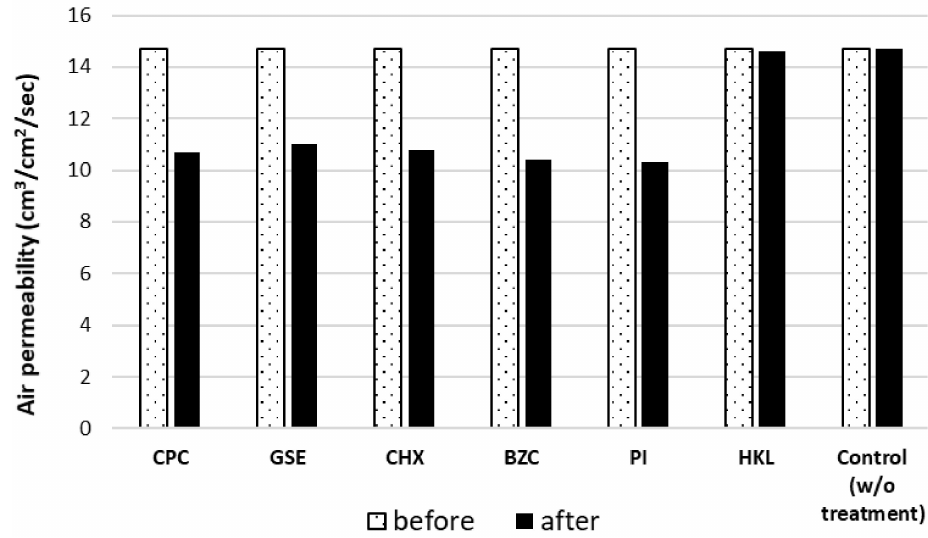
Figure 4. Air permeability of masks before/after silica-resin coating technology treatment.